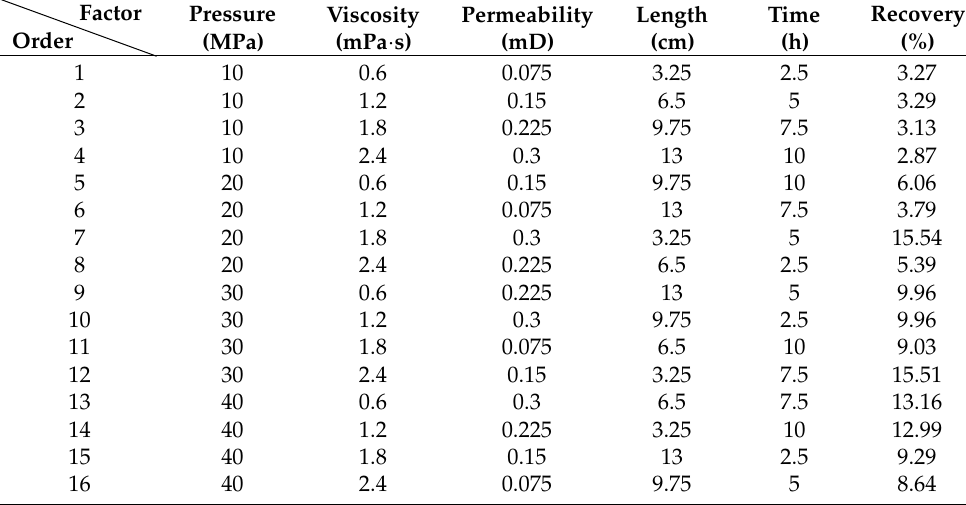
Table 4. Orthogonal test calculation results.